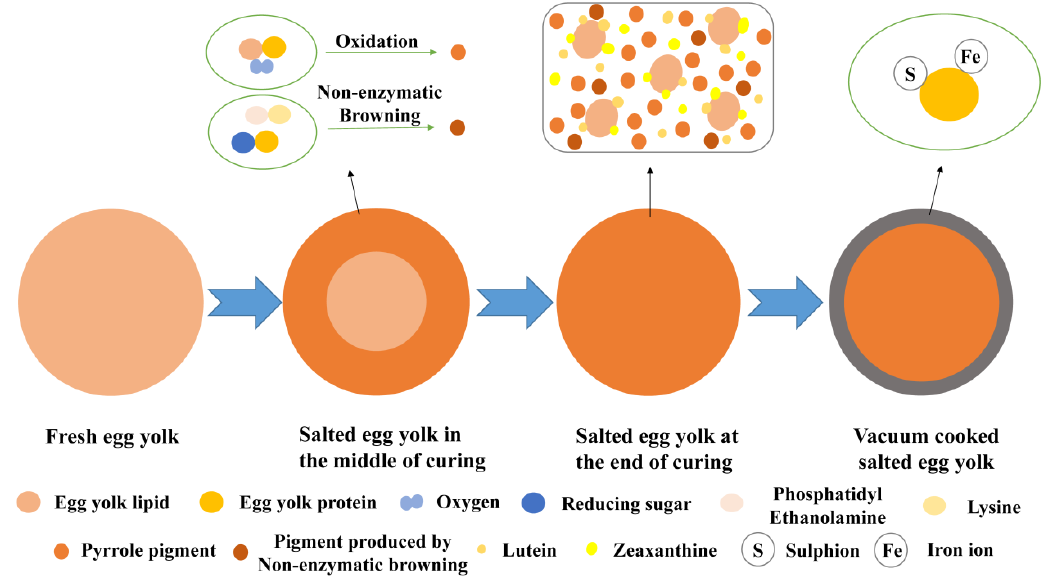
Figure 4. Color formation mechanism of salted egg yolk.